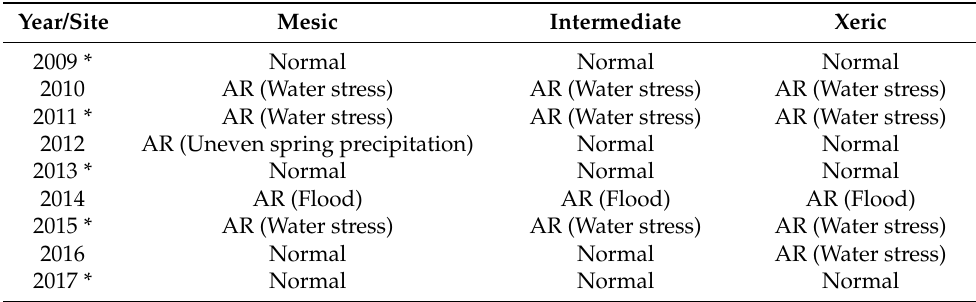
Table 2. Description of the application of the phenology model for the three EC sites at the JCI, Newton, GA, USA.